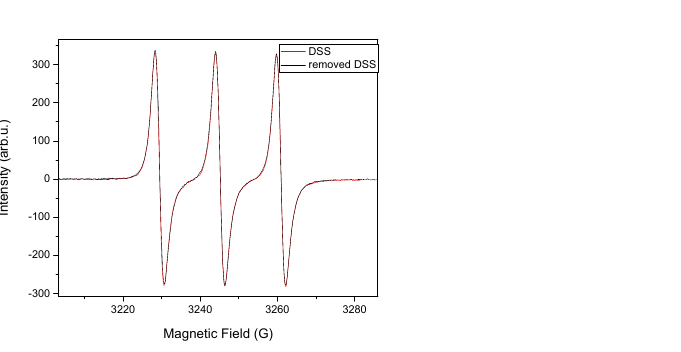
Figure 6. Electron paramagnetic resonance (EPR) spectra of removed DSS from PCL/12.5%DSS mat (black line) and the commercial DSS (red line) in DCM/DMF solution in the presence of TEMPO • .